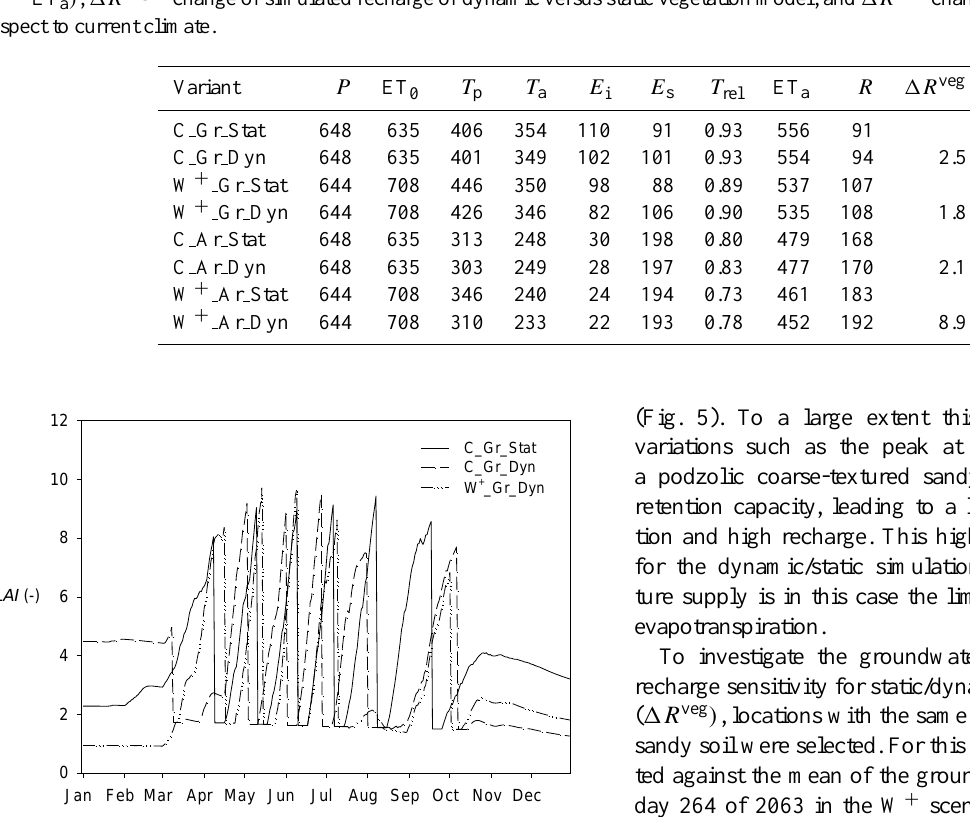
Fig. 9. Simulated leaf area index of grassland at evaluation point Figure 9. Simulated Leaf Area Index of grassland in evaluation point EP1 (Fig. 5), for three of 2 EP1 (Fig. 5), for three of the variants (Table 3): C Gr Stat – static the variants (Table 3): C_Gr_Stat – static vegetation model current climate, C_Gr_Dyn – 3 vegetation model current climate, C Gr Dyn – simulation with dy- namic vegetation model, current climate; W + Gr Dyn - simulation simulation with dynamic vegetation model, current climate; W + _Gr_Dyn - simulation with 4 with dynamic vegetation model, W + -scenario. dynamic vegetation model, W + -scenario. 5 The simulations are for the year 2003 (warm year, current climate) and 2063 (W +